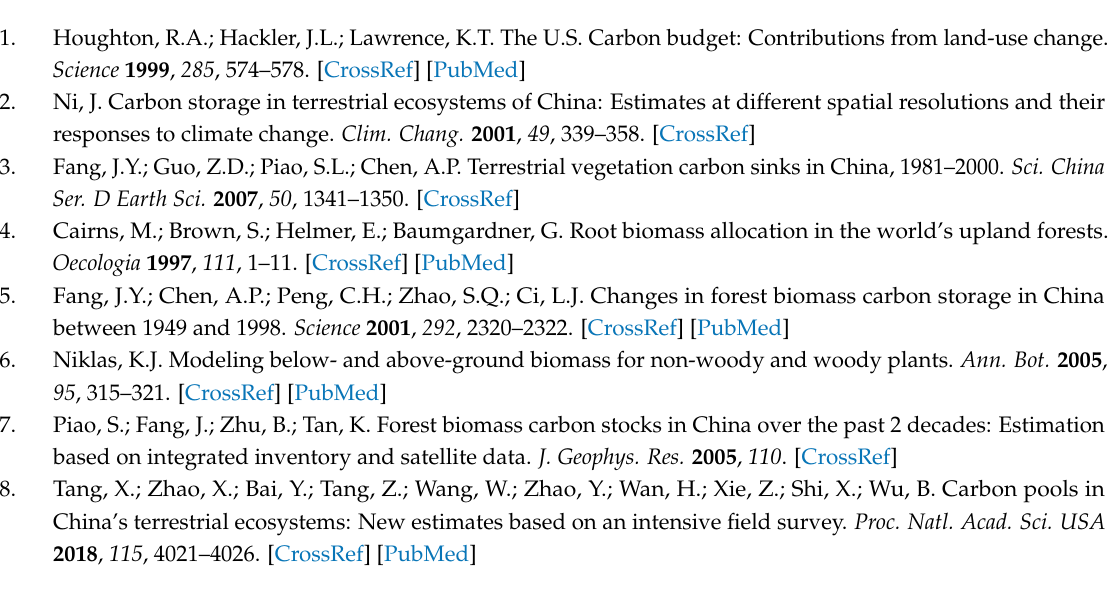
Table S1: Original